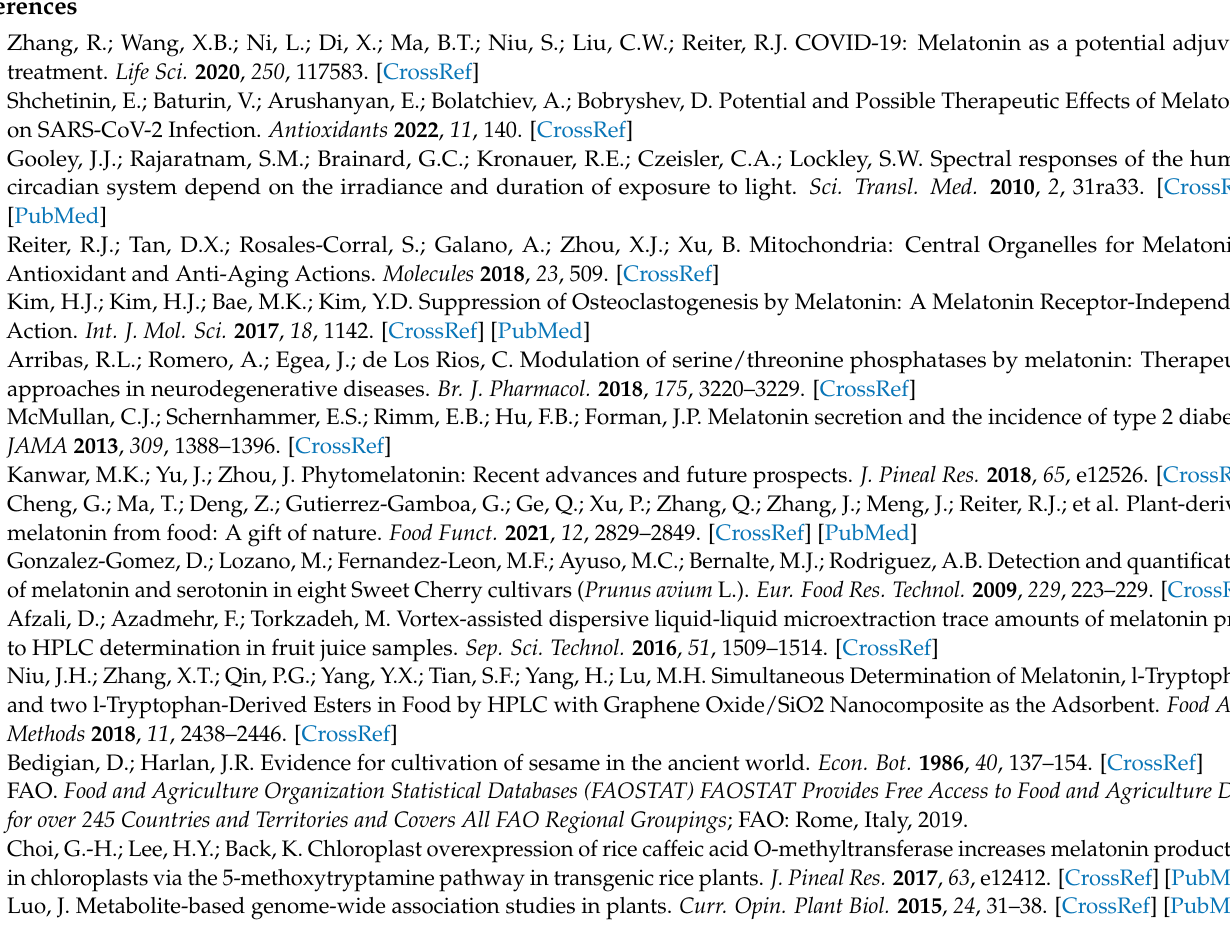
Figure S2. Extraction ion chromatograms of melatonin; Figure S3. The expressional levels of potential candidate genes associated with melatonin content in sesame seed at different stages of development. Heat maps were constructed based on the log10-transformed RPKM values for each gene. The color scale for expression values is shown. DAF: days after flowering; Figure S4. Expression of SiWRKY67 in SiWRKY67-overexpressing transgenic hairy root lines. Error bars indicate SE based on three replicates. VC: empty vector control; Table S1. The list of 450 accessions sampled in the